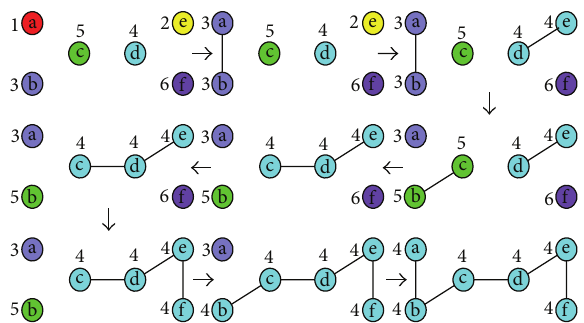
Figure 3: Network construction